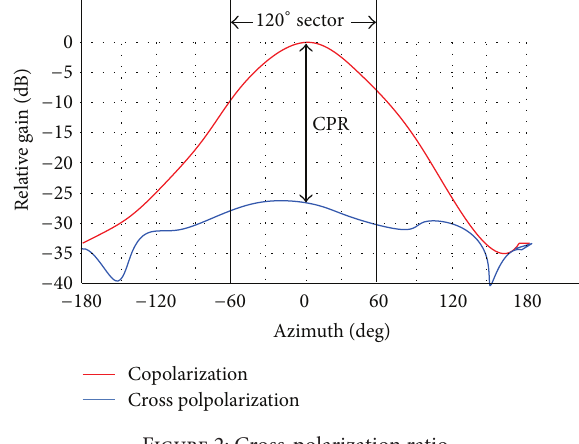
Figure 2: Cross-polarization